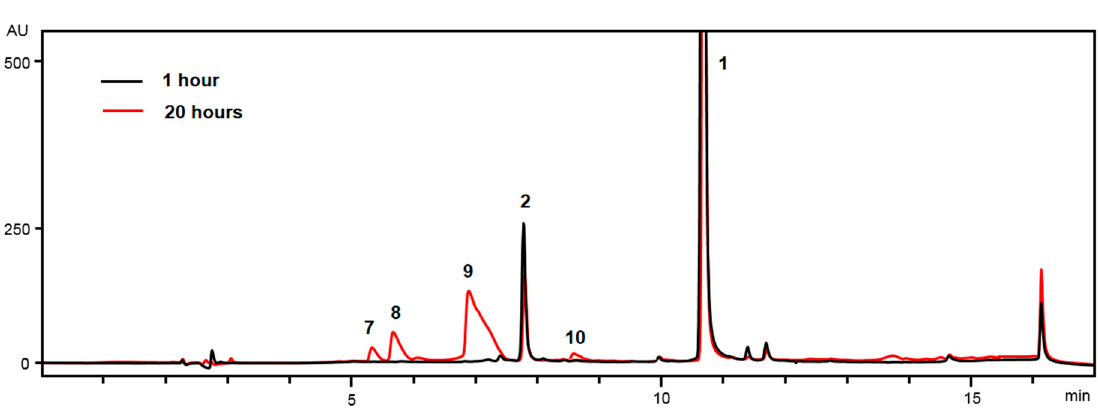
Figure 2. HPLC profiles of Histochrome (Ech A) oxidation products. Unmarked peaks are natural impurities of the Ech A substance [24].